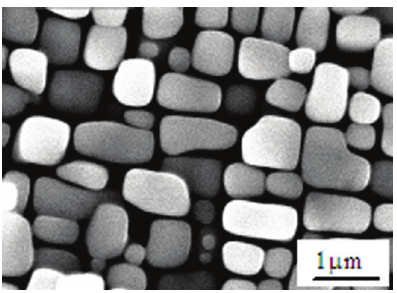
Fig. 1: γ′ phase of aged